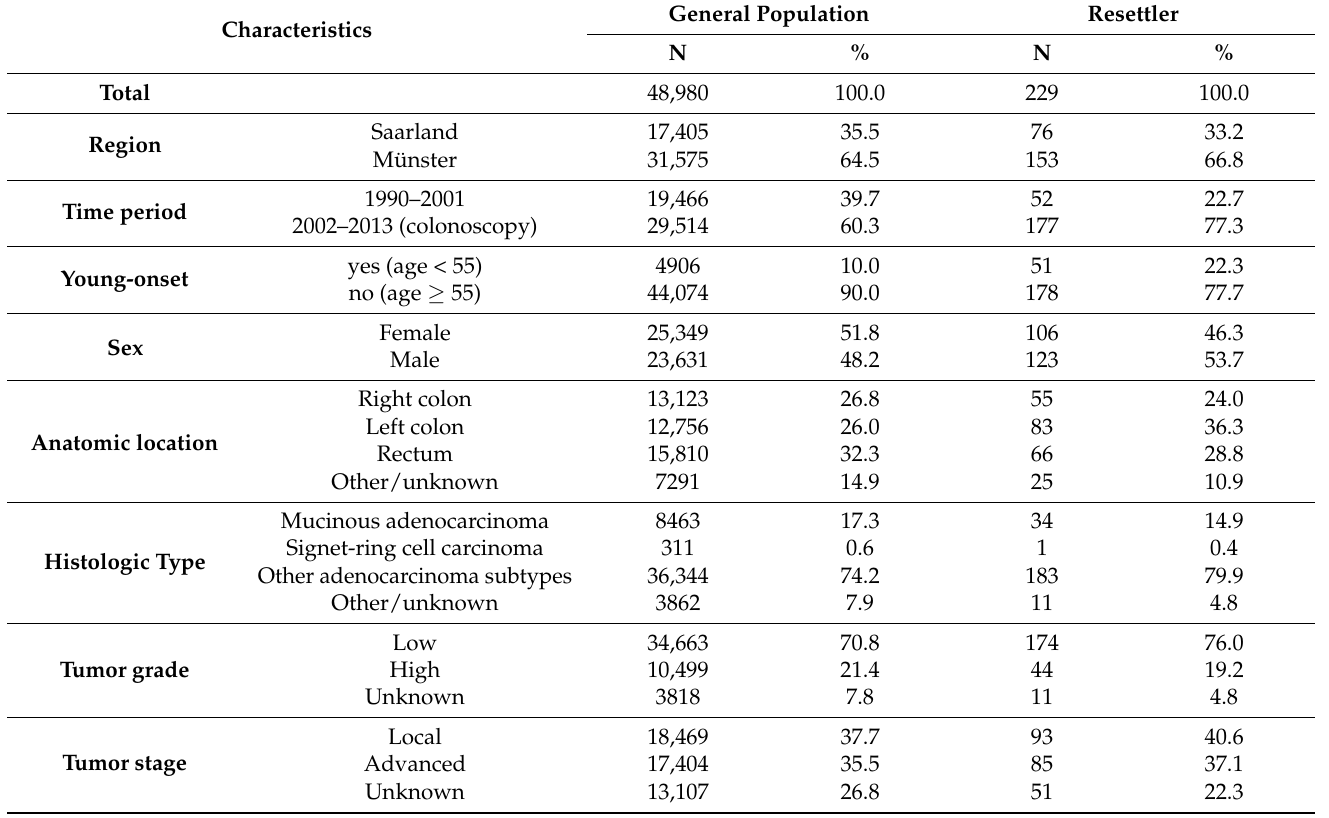
Table 1. Demographic characteristics and clinical and pathological characteristics of CRC among resettlers and in the general population (Saarland, 1990–2009 and Münster,